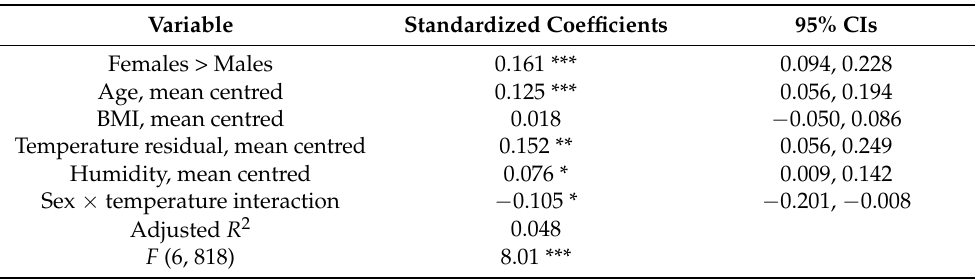
Table 1. Summary of the effects of individual differences and climate variables on estimates of stair slant in degrees.